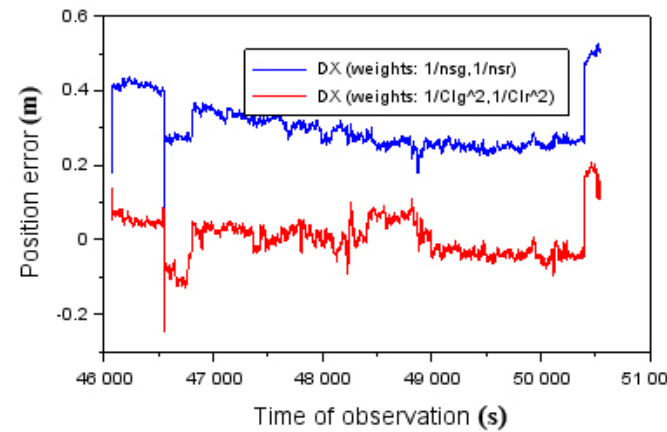
Figure 13. Position errors along the X -axis.